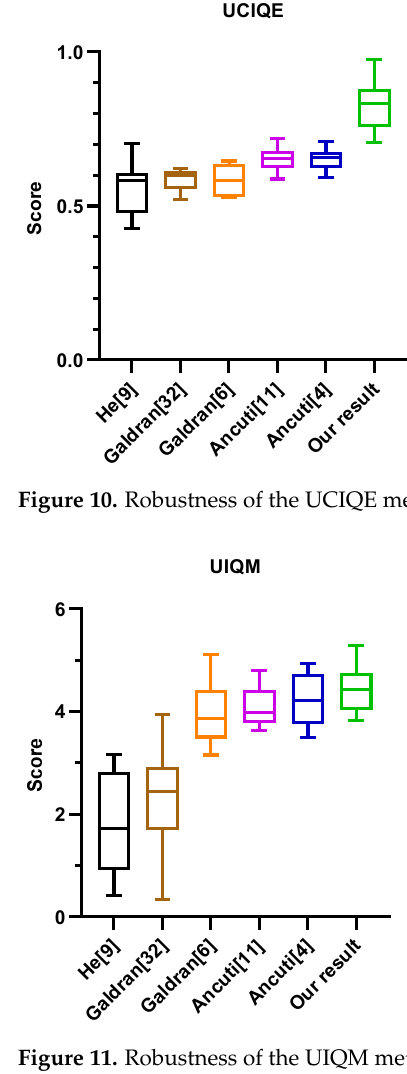
Figure 12. The first row contains the original pair of images with two SIFT features matching in the first column and one in the second column. The second row contains the enhanced pair of images using the proposed method with 16 SIFT features matching in the first and second columns.